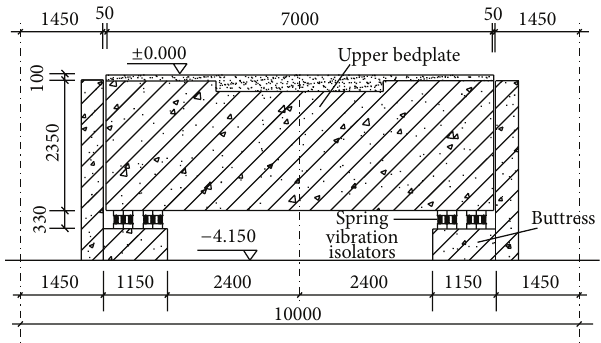
Figure 1: Spring vibration-isolated foundation of medium-speed mill.